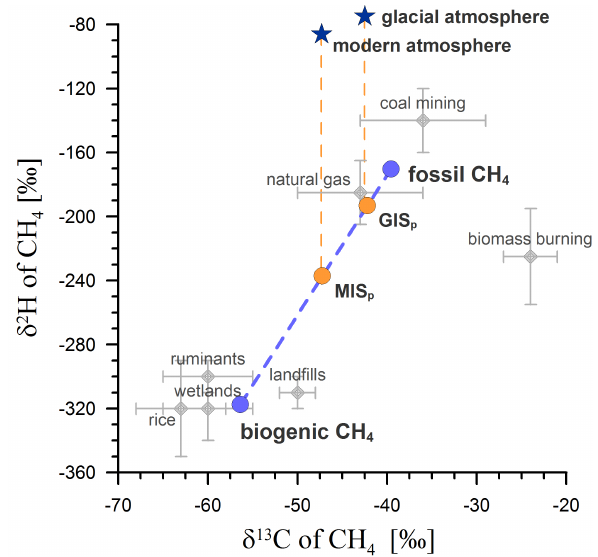
Fig. 1. Dual isotope signatures of CH 4 for δ 13 C and δ 2 H. Grey diamonds mark the field of δ 13 C and δ 2 H isotopes of CH 4 according to its source (Quay et al., 1999). Blue circles indicate δ 13 C and δ 2 H pairs of the parental CH 4 gases (fossil and biogenic CH 4 ). Based on our fossil and biogenic CH 4 , we can produce filial CH 4 mixtures with δ 13 C and δ 2 H isotope values that fall on the dashed blue mixing line. The two filial CH 4 gas mixtures are indicated by orange circles where GIS p and MIS p represent the δ 13 C of glacial and modern atmospheric samples, respectively. Isotope signatures of glacial and modern atmospheric CH 4 are indicated by the dark blue stars.